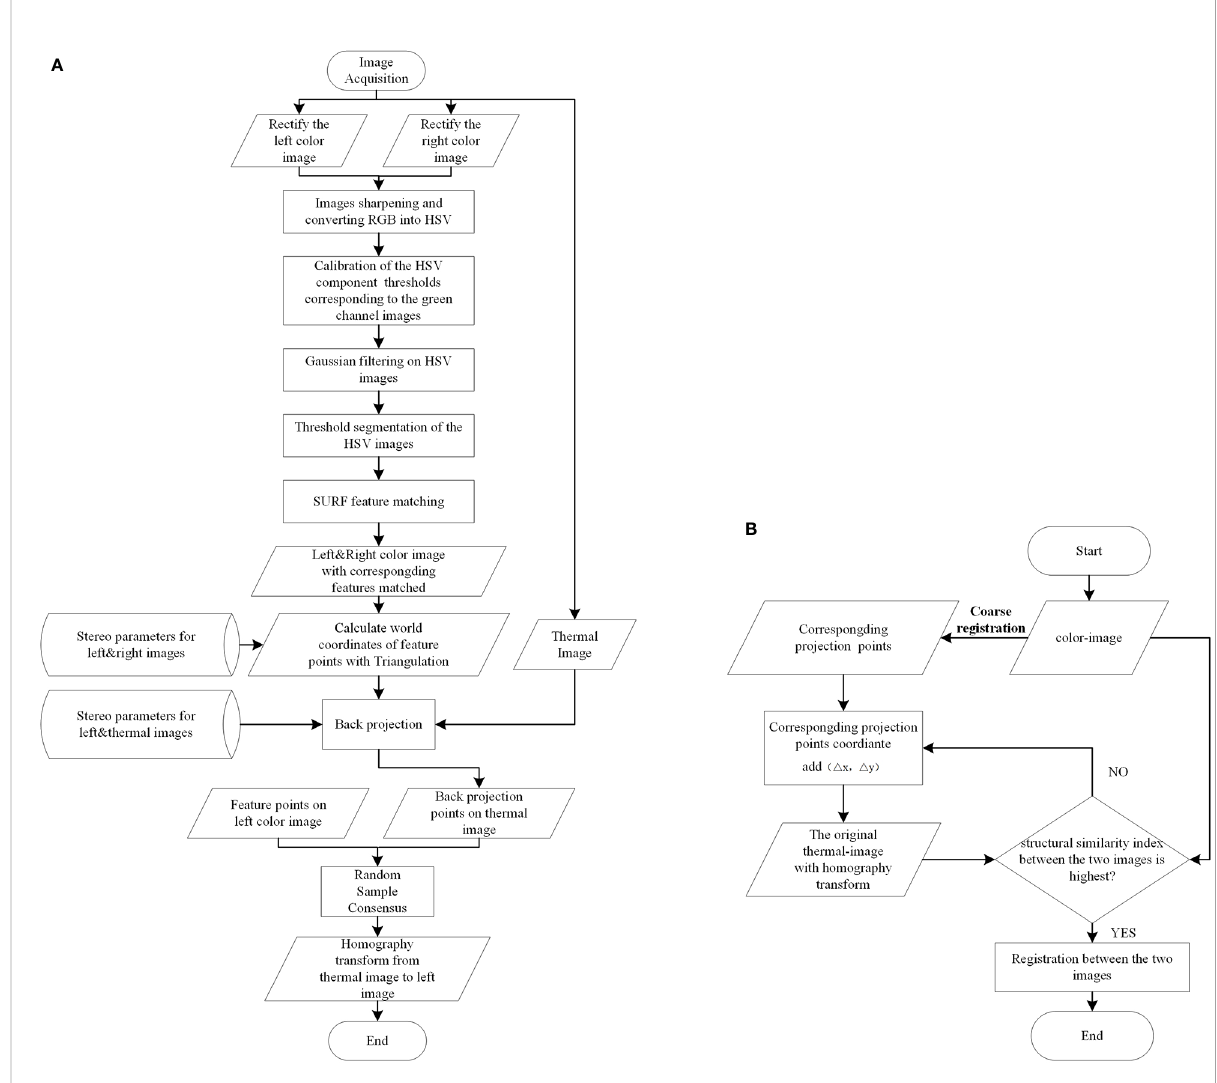
FIGURE 4 Work fl ow of the (A) coarse registration method and (B) fi ne registration